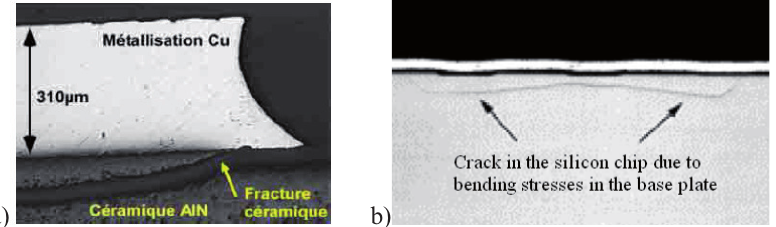
Fig. 4. Fracture of ceramic substrates (a) [4] and silicon chip (b) [3].